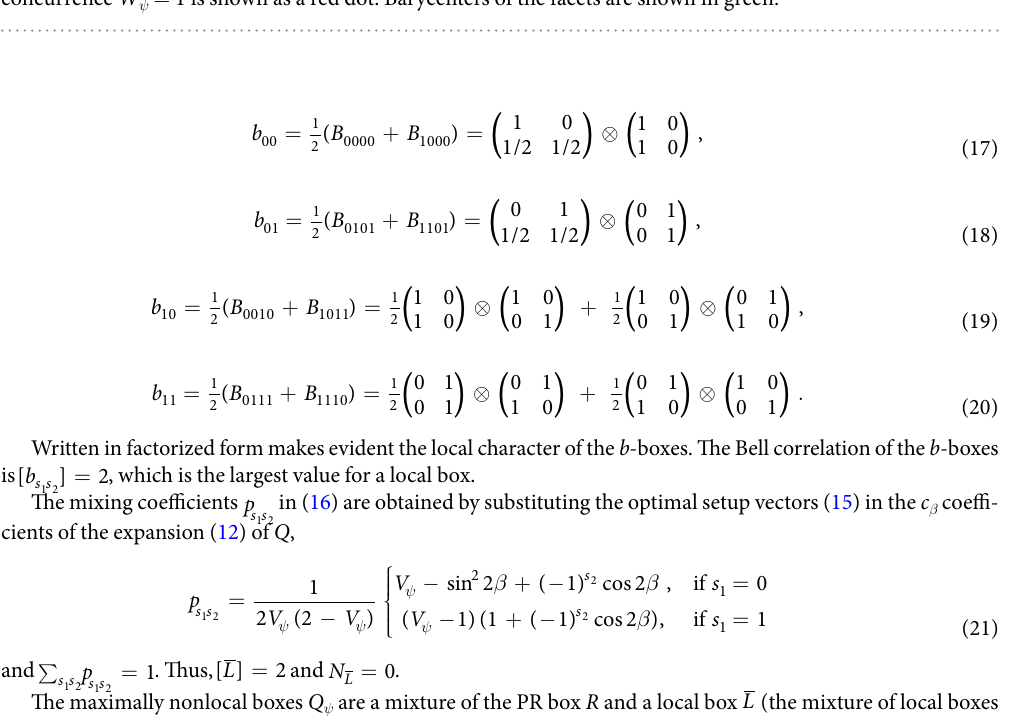
Figure 2. Locus of maximally nonlocal quantum boxes Q ψ (in blue) projected into the five facets of the simplex Δ 4 . The box Q ≈ 0.414, stemming from a maximally entangled state of ψ with the strongest nonlocality ψ N Q ( concurrence W ψ = 1 is shown as a red dot. Barycenters of the facets are shown in